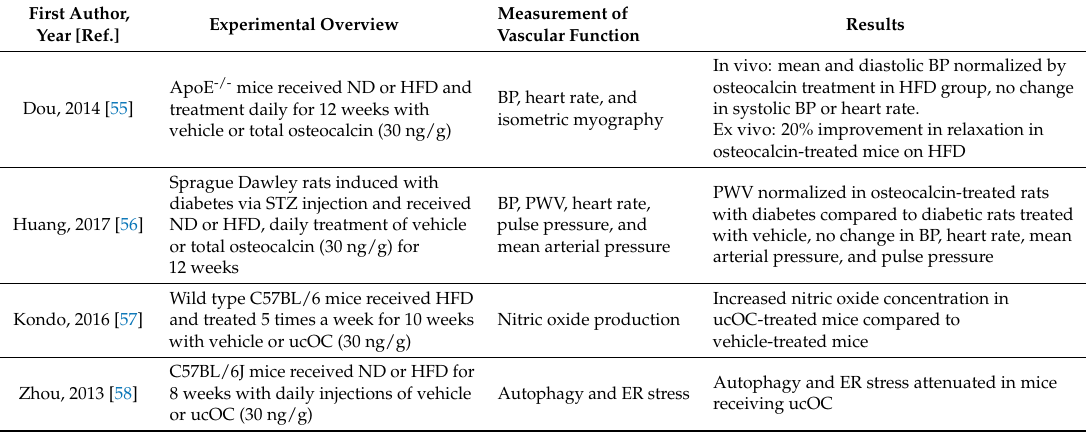
Table 1. Summary of studies examining the effects of in vivo osteocalcin treatment on vascular function outcomes in